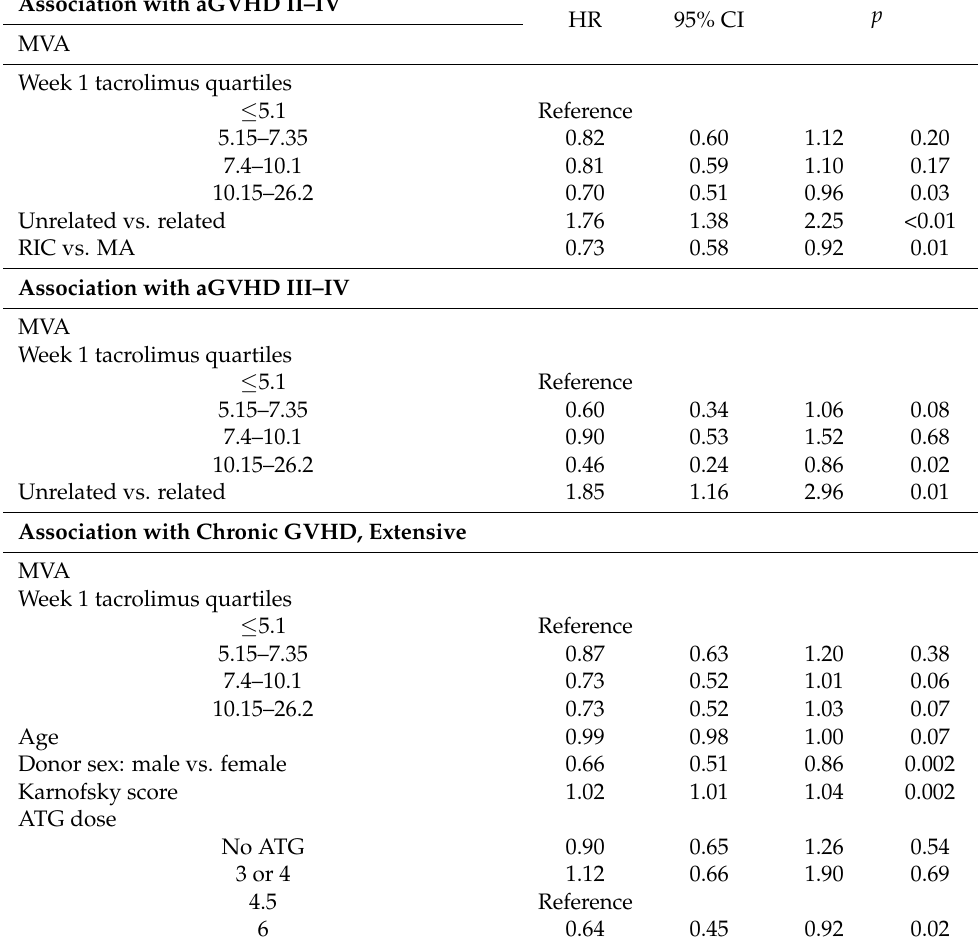
Table 2. Multivariable analysis for factors affecting the incidence of aGVHD and